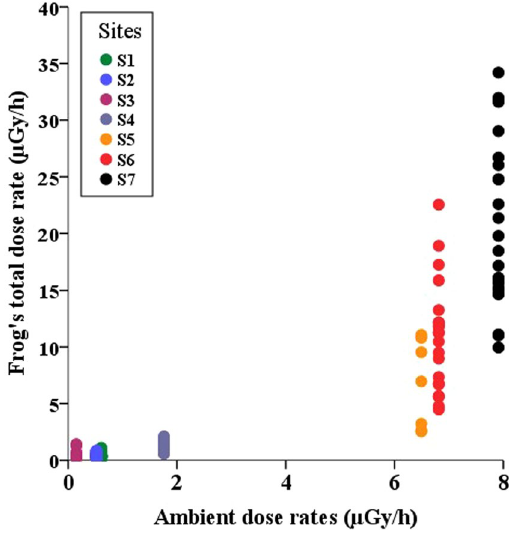
Figure 2. Total individual dose rate (TDR, µ Gy/h) in frogs and ambient dose rates at the seven